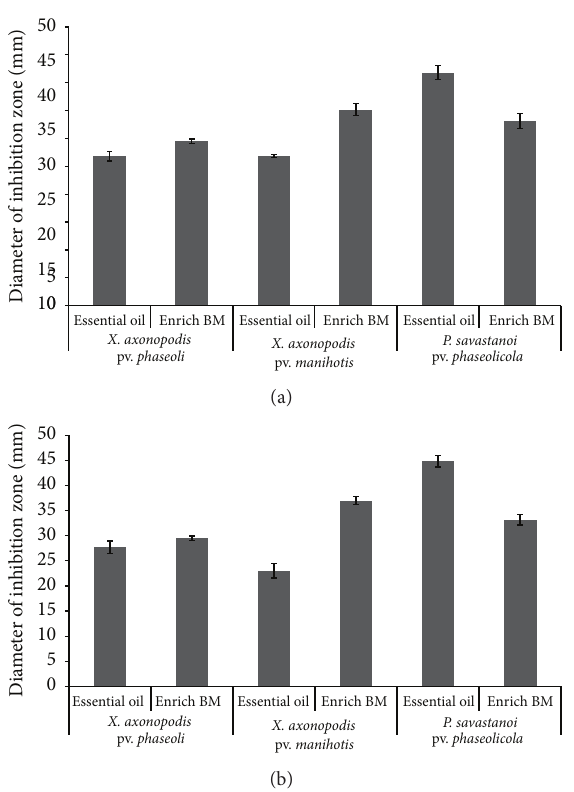
Figure 2: Growth inhibition of the test bacteria by T. minuta essential oils and Enrich BM after 24 hours (a) and 48 hours (b). Error bars represent standard error of mean.